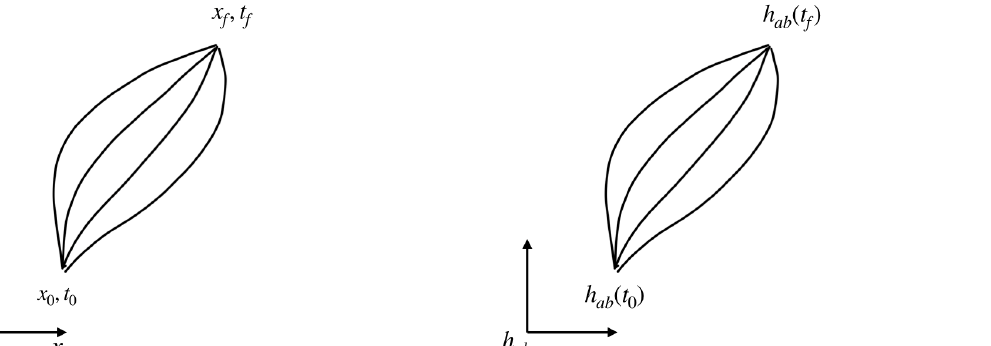
Figure 3. ( Left ): path integral in spacetime. ( Right ): path integral in quantum